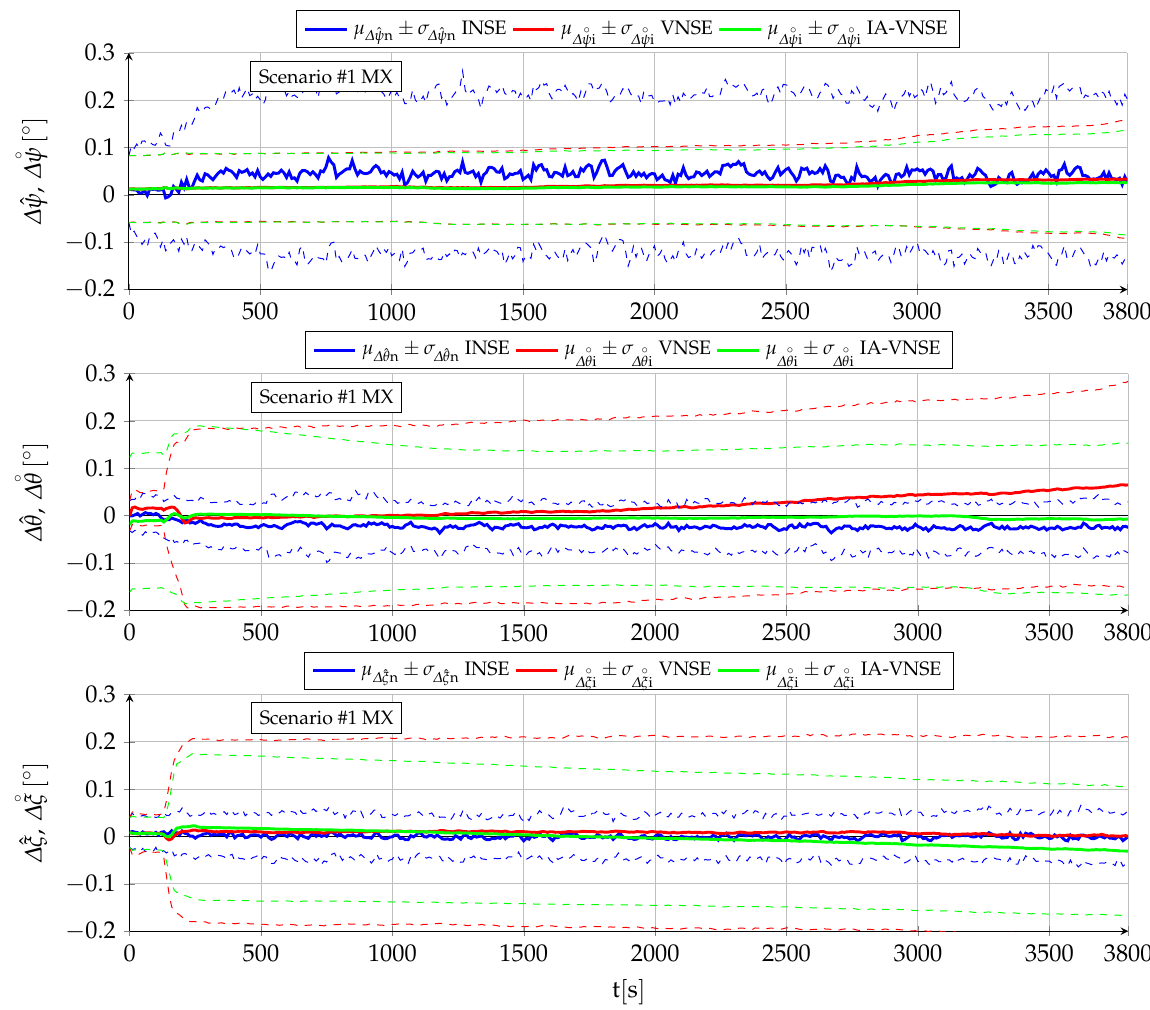
Figure 10. Body Euler angles INSE, VNSE, and IA-VNSE for scenario #1 MX (100